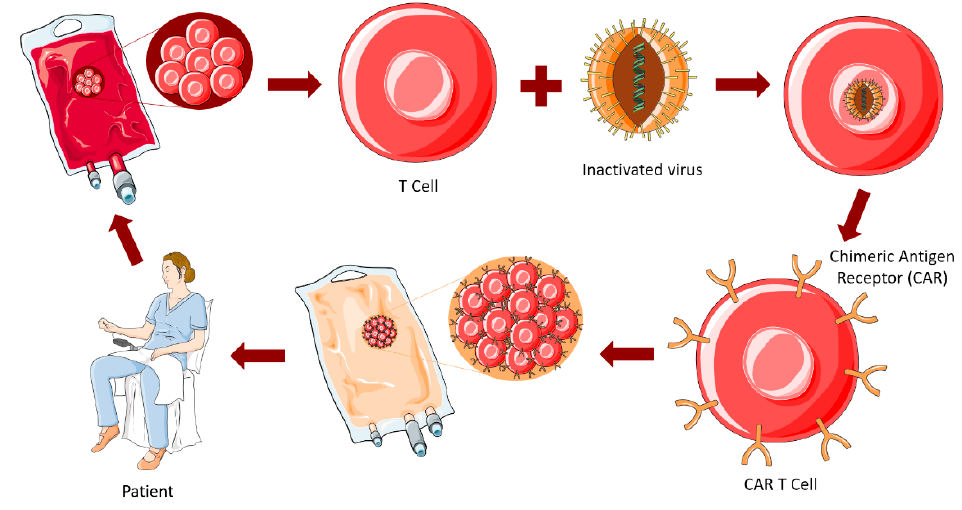
Figure 9. CAR ‐ T cell therapy. Figure drawn with smart.servier.com. Figure 9. CAR-T cell therapy. Figure drawn with